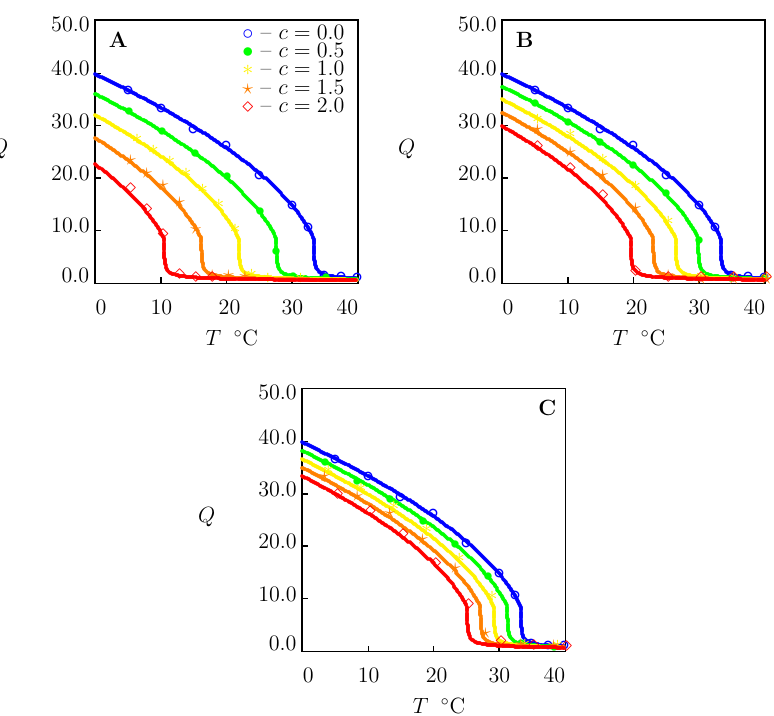
qqqqqqqqqqqqqqqqqqqqqqqqqqqqqqqqqqqqqqqqqqqqqqqqqqqqqqqqqqqqqqqqqqqqqqqqqqqqqqqqqqqqqqqqqqqqqqqqqqqqqqqqqqqqqqqqqqqqqqqqqqqqqqqqqqqqqqqqqqqqqqqqqqqqqqqqqqqqqq Figure 2. Equilibrium degree of swelling Q versus temperature T . Circles: experimental data on PNIPAAm gel [38] in aqueous solutions of salts with various concentrations c M. ( A )—NaCl, ( B )—NaBr, ( C )—NaI. Solid lines: results of numerical analysis.